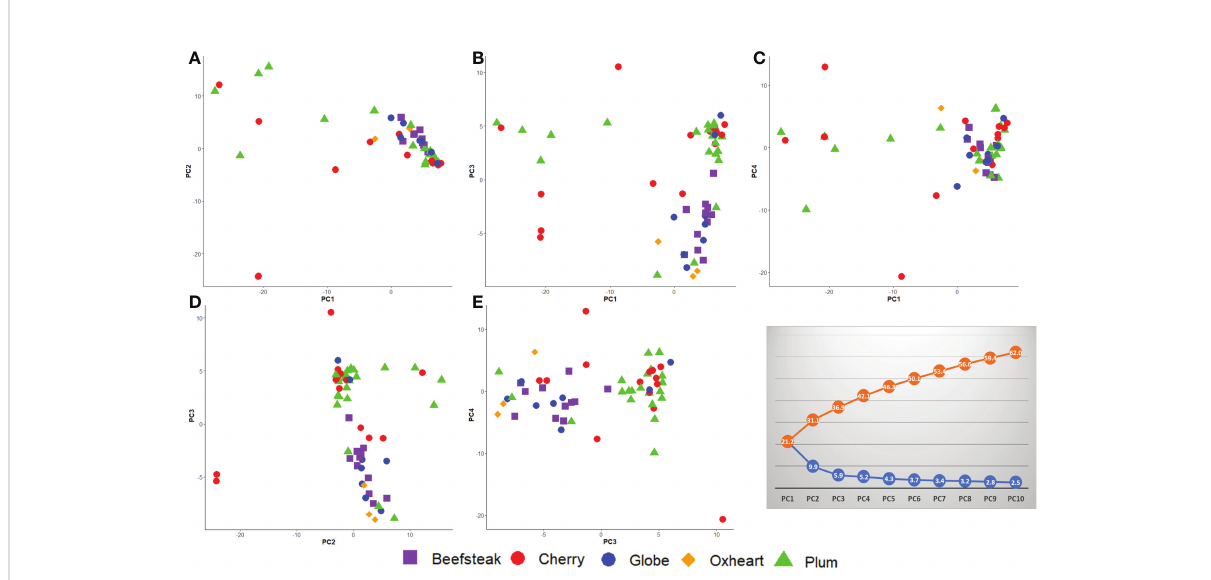
FIGURE 7 Loading plots in the fi rst four components, showing the genomic diversity of 60 studied tomato accessions. (A) PC 1 vs. PC 2 ; (B) PC 1 vs. PC 3 ; (C)